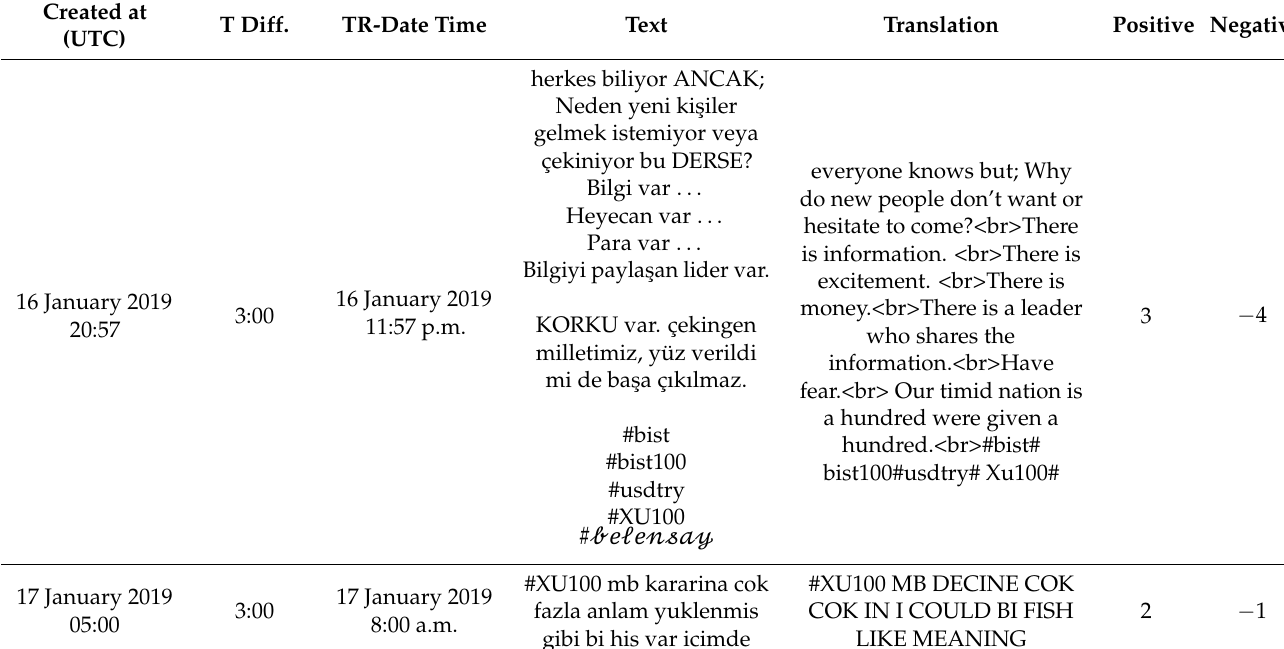
Table 3. The example steps of data cleaning.